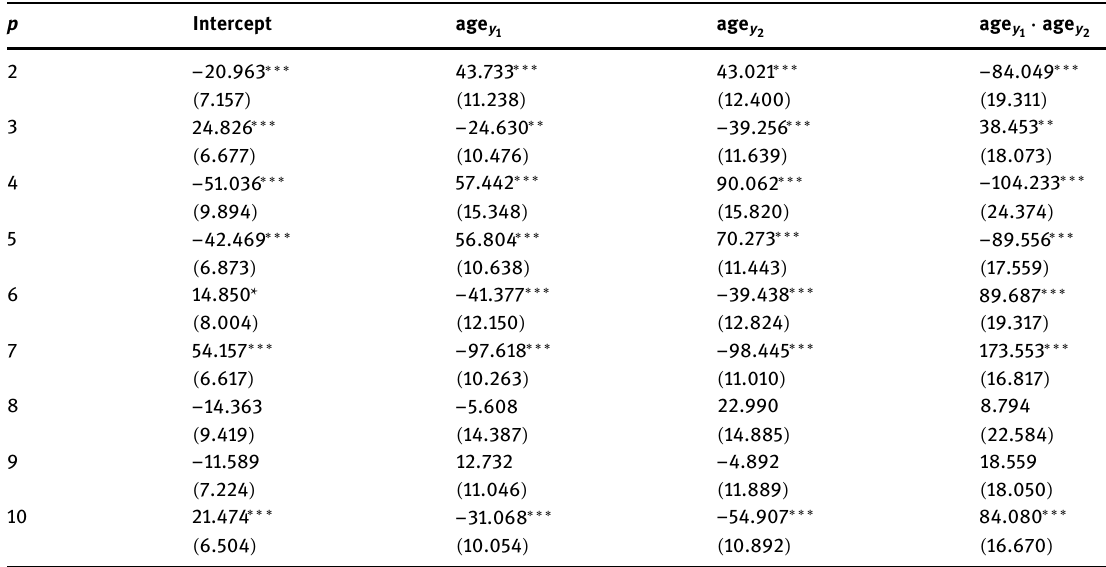
Table 1: Coe ffi cients of multinomial regression with associated standard errors in